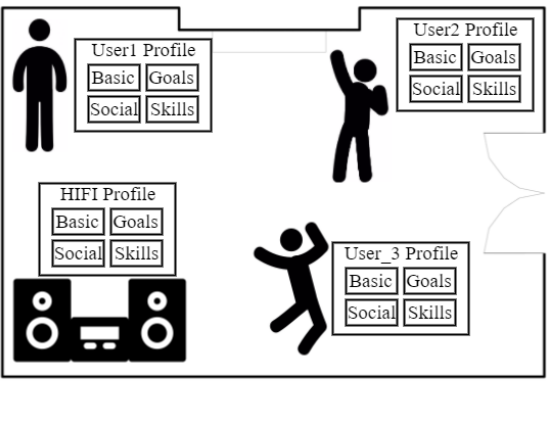
Figure 1. Example of the situational